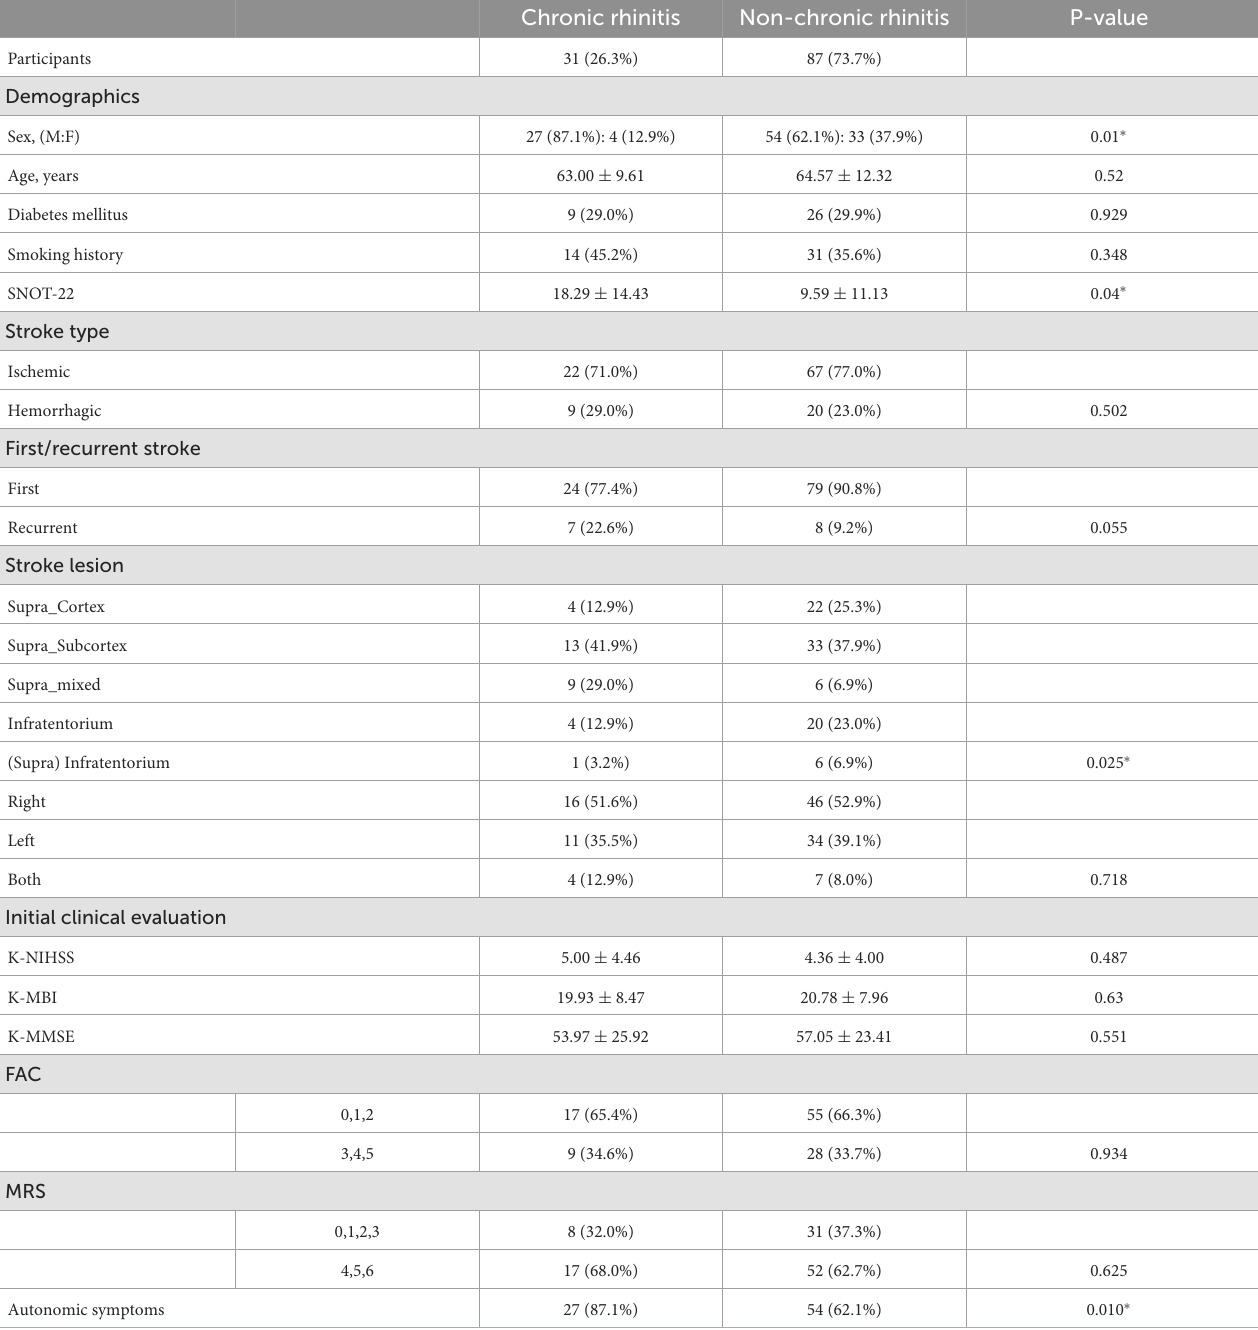
TABLE 2 Participants’ demographics, smoking history, SNOT-22 score, and clinical characteristics related to stroke ( N =